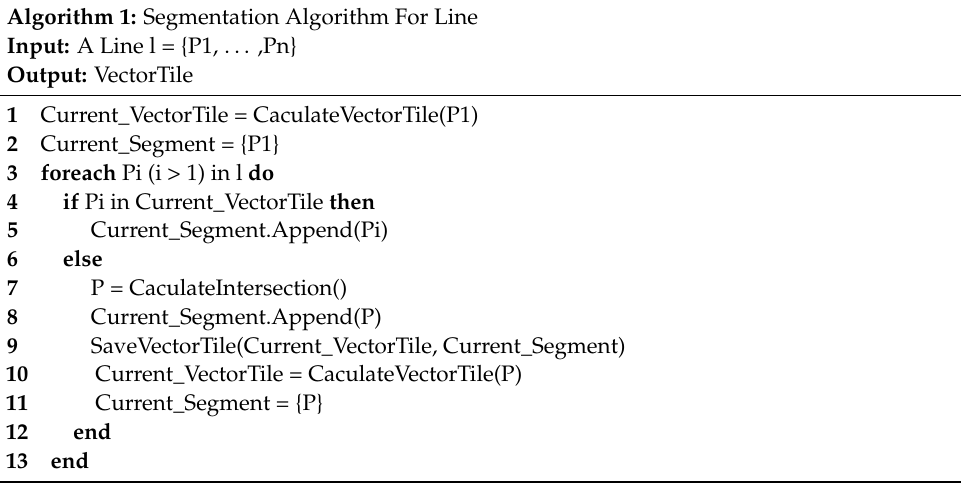
Algorithm 1: Segmentation Algorithm For